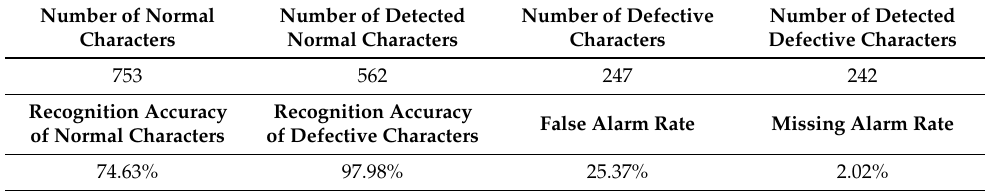
Table 7. Character Proportion Matching (CPM) [21] results of character recognition.